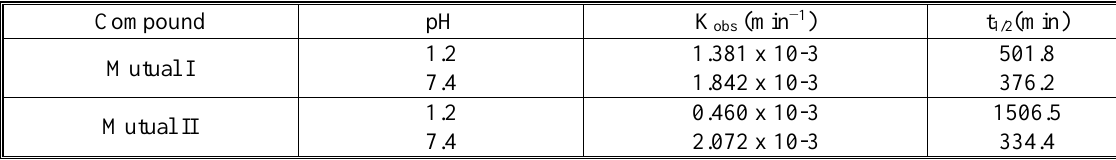
Table 5. Kinetic data for the chemical hydrolysis of the mutual prodrugs